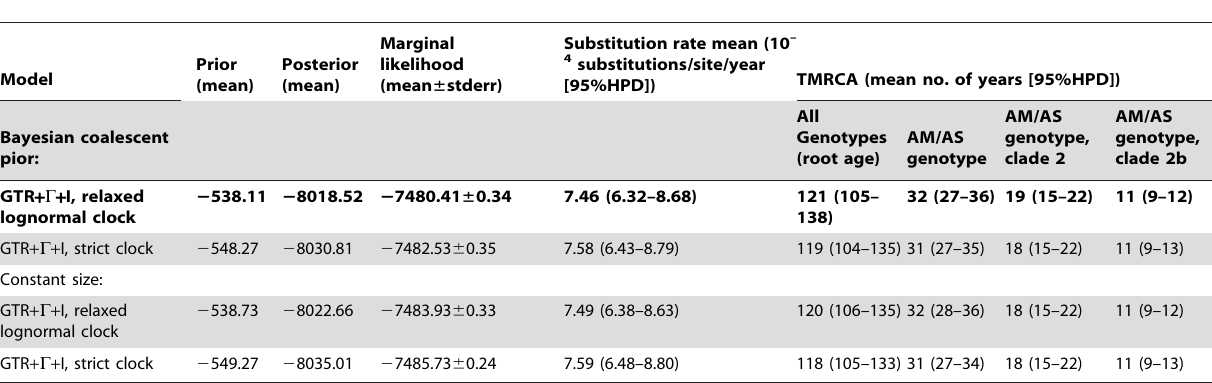
tutions/site/year. The MCC tree generated under the best fit model and the Bayesian Skyline (BS) plot analysis for Central American DENV-2 strains of AM/AS genotype are shown in Figure 3. The TMRCA for all genotypes (excluding sylvatic strains, n = 115) was between 105 and 138 years, mean of 121 years, which is congruent with previous findings [10]. In the case of the AM/AS genotype, the TMRCA appears to have only existed recently, around 32 years ago (95% HPD: 27–36). Between clades 1 and 2 of the AM/AS genotype, the TMRCA was about Table 2. Molecular clock analysis of DENV-2 from all genotypes used in the study without including sylvatic strains.